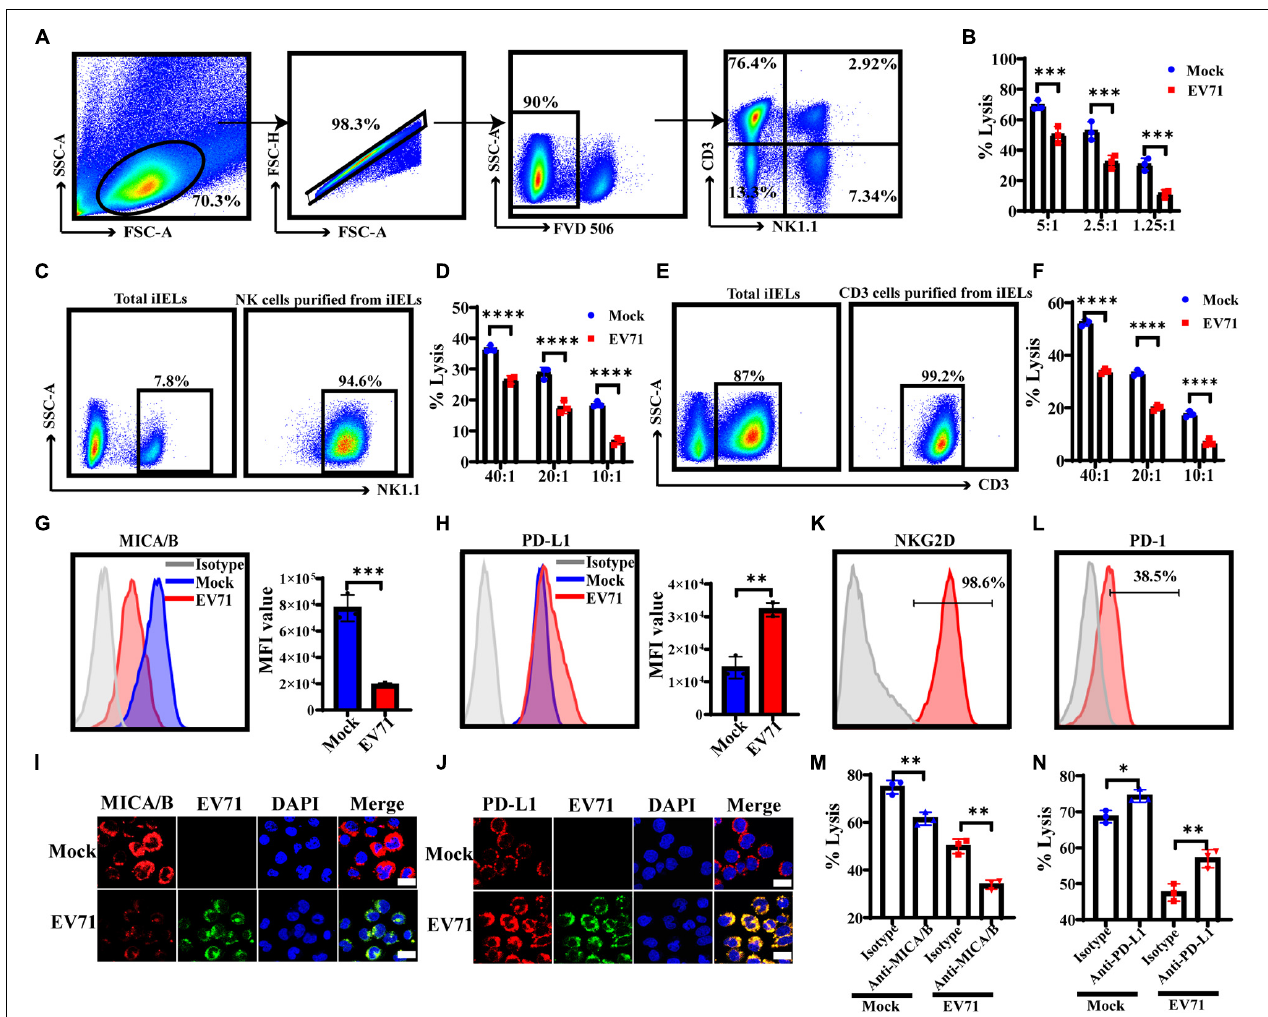
FIGURE 7 | EV71 + IECs express lower levels of MICA/B and higher levels of PD-L1 and are less susceptible to iNK and CD3 + iIELs lysis. (A) The intestinal intraepithelial lymphocytes from the C57BL/6 mouse were separated and extracted, and the ratio of CD3 + iIELs and NK1.1 + iNK cells was analyzed by flow cytometry. (B) HT29 cells were infected with EV71 at an MOI of 1 for 48 h. LDH was applied to analyze the susceptibility of EV71 - HT29 and EV71 + HT29 to NK-92 cell lysis at 6 h at the indicated E:T ratios. (C,E) The intestinal intraepithelial lymphocytes were prepared to enrich iNK or CD3 + iIELs using the MojoSortTM Mouse NK Cell Isolation Kit or the MojoSortTM Mouse CD3 T Cell Isolation Kit by MACS. Cells were stained with anti-NK1.1 antibody or anti-CD3 antibody. (D,F) The h-SCARB2-MC38 cells were infected with EV71 at an MOI of 1 for 48 h. LDH was applied to analyze the susceptibility of EV71 - h-SCARB2-MC38 and EV71 + h-SCARB2-MC38 to iNK or CD3 + iIELs cell lysis on 10 h at the indicated E:T ratios. (G,H) HT29 cells were infected with EV71 at an MOI of 1. The membrane expression levels of MICA/B or PD-L1 were detected at 48 hpi by FACS. (I,J) At 48 hpi, cells were fixed and stained with anti-EV71 (green) antibodies, anti-MICA/B or PD-L1 (red) antibodies, and DAPI (blue) and examined by a confocal microscope. Mock was cells without infection. Merged images of the different channels were shown. (K,L) The expression levels of NKG2D or PD-1 on NK-92 were detected by FACS. (M,N) The EV71 - HT29 and EV71 + HT29 were pre-incubated with saturating concentrations of anti-MICA/B Ab (10 µ g/ml) or anti-PD-L1 Ab (10 µ g/ml), or isotype-matched control antibody at 37 ◦ C for 2 h and then washed for use as target cells. The NK-92 cells and treated HT29 were co-incubated for 6 h, and the cytotoxicity of NK-92 cells was detected at an E:T ratio of 5:1 on 6 h by LDH assay. Dates were presented as mean ± SD ( n = 3 independent experiments, ∗ P < 0.05, ∗∗ P < 0.01, ∗∗∗ P < 0.001, and ∗∗∗∗ P <